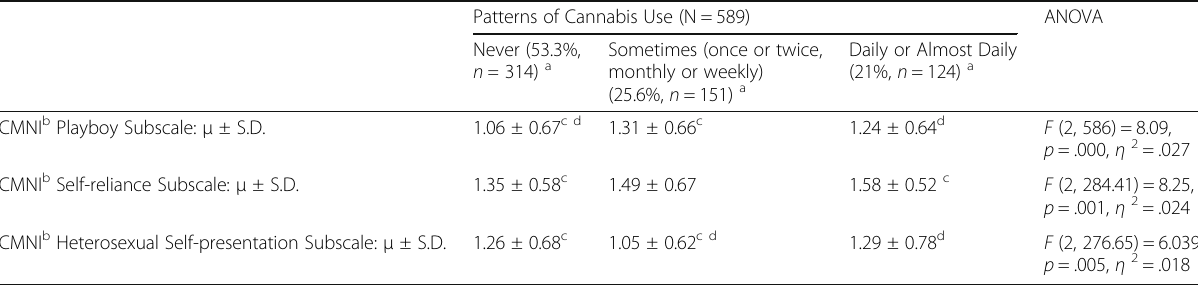
Table 3 Patterns of cannabis use in past year by conformity to masculine norms ( N = 589)